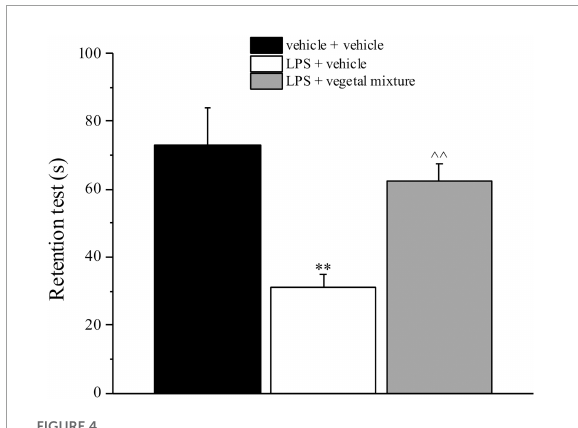
FIGURE4 Effect of a vegetal mixture on LPS-induced memory loss. LPS (1 mg kg - 1 ) was intraperitoneally injected on days 1, 3, 5, and 8. The vegetal mixture was composed of Zingiber officinale (150 mg kg - 1 ), Echinacea purpurea (20 mg kg - 1 ), and Centella asiatica (200 mg kg - 1 ), suspended in 1% carboxymethylcellulose sodium salt (CMC) and orally administered daily starting